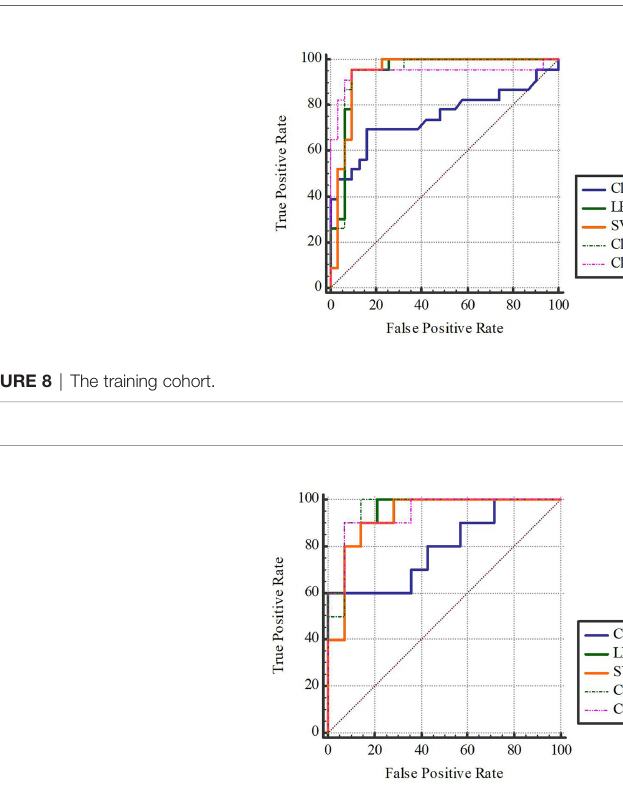
FIGURE 9 | The validation cohort. Figures 8 , 9 The ROC curve of clinical features, radiomic, clinical features + radiomic model in the training and validation cohorts.